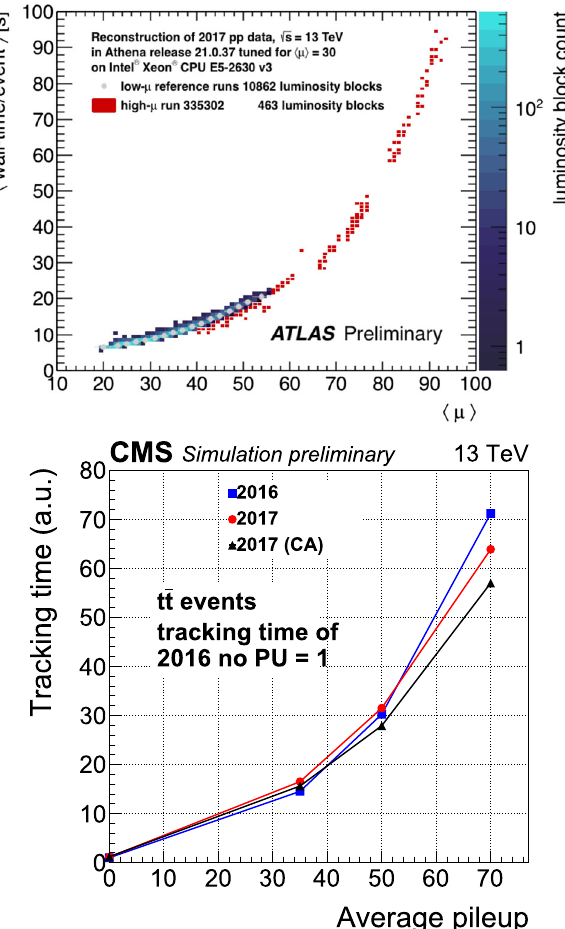
Fig. 2 Reconstruction wall time per event as a function of the average number of interactions per bunch crossing (cid:2) μ (cid:3) . Top: ATLAS Run 2 Inner Detector reconstruction with default configurations [10]. Bottom: CMS time spent in tracking sequence for 2016 tracking, 2017 tracking with conventional seeding, and 2017 tracking with Cellular Automaton (CA) seeding